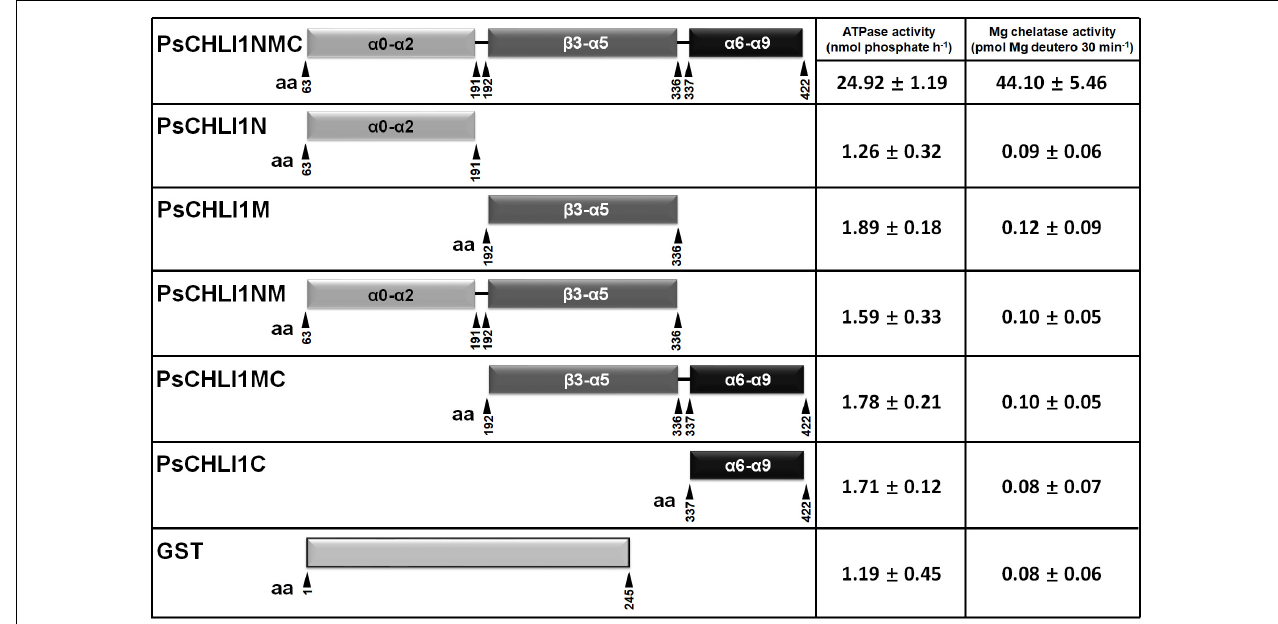
FIGURE 6 | Peptide fragments of PsCHLI1 for enzyme activity. The different fragments of 1 µ M PsCHLI1 and GST purified from E. coli were used to determine ATPase activity by the Malachite Green colorimetric assay. The different fragments of 0.2 µ M PsCHLI1 and GST purified from E. coli were combined with recombinant rice CHLD (0.05 µ M), CHLH (0.5 µ M), and GUN4 (0.5 µ M) proteins to reconstitute the Mg-chelatase activity in vitro by a stopped fluorometric assay. Data represent the mean ± S.E.M of nine replications from three independent assays. Differences between the GST group and groups of the PsCHLI1 fragments were assessed with analysis of variance. Secondary structure elements in the different peptide fragments are shown in the boxes. α , α -helices; β , β